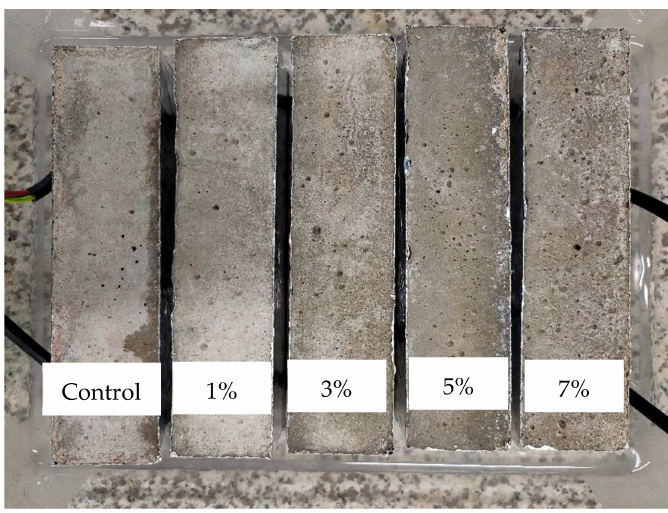
Figure 3. BSC mortar